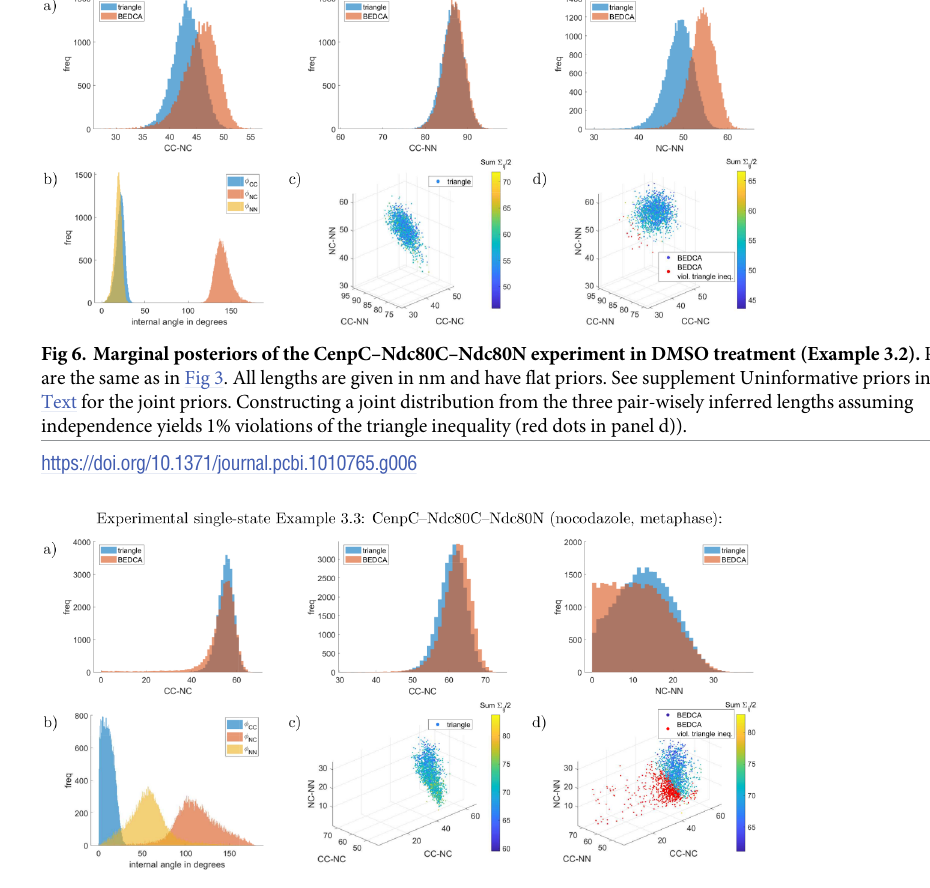
Fig 7. Marginal inferred posteriors of the CenpC–Ndc80C–Ndc80N experiment in nocodazole treatment (Example 3.3). Panels are the same as in Fig 3. All lengths are given in nm and have flat priors. See supplement Uninformative priors in S1 Text for the joint priors. Constructing a joint distribution from the three pair-wisely inferred lengths assuming independence yields 39% violations of the triangle inequality (red dots in panel d)).